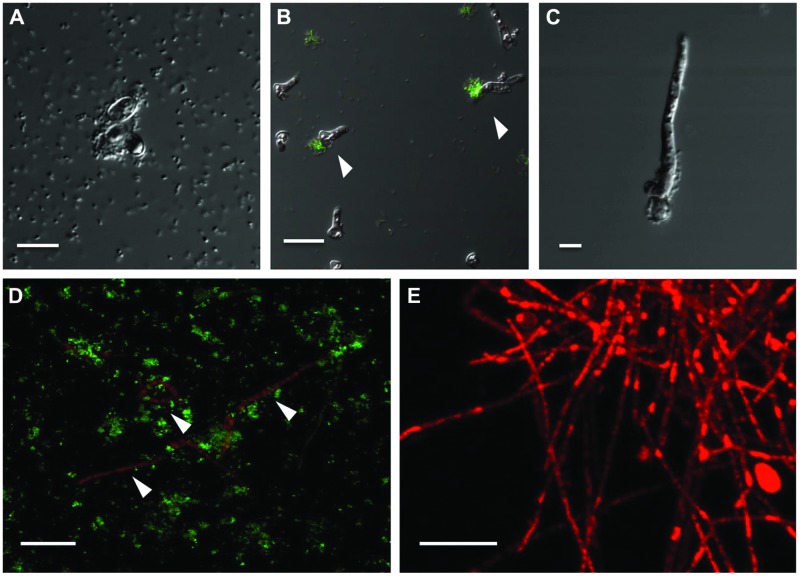
Adhesion and colonization of mCherry-tagged S. aurantiacum strain WM 06.482 (shown in red) by P. aeruginosa strain PASS1 tagged with yfp (shown in green) during coculturing in SCFM for 24 h at 37°C. Scale bar = 20 μm. (A)
P. aeruginosa cells adhered to germinating S. aurantiacum conidia after 2 h of incubation as viewed by DIC. (B,C) after 8 h, some young hyphae were surrounded by bacterial cells. (D) Bacteria can be seen attached to the hyphal filaments after incubation for 24 h. (E) Healthy growing culture of WM 06.482 expressing mCherry in the absence of bacteria. ∗White arrows indicate fungal filaments that are being colonized by the bacteria.